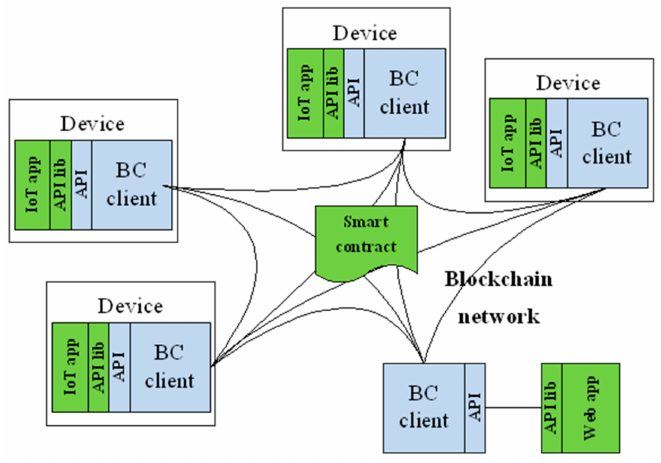
Figure 1. Ethereum’s decentralized application architecture for the